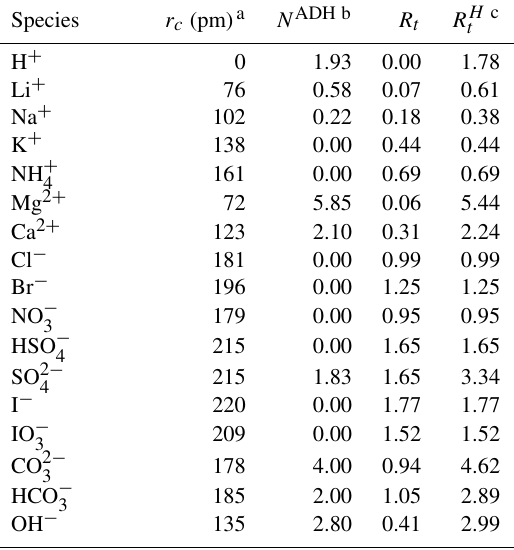
Table 1. Relative van der Waals ionic volume ( R H t ) parameters for cations and anions considering apparent dynamic hydration. Table adapted from Zuend et al. (2008).